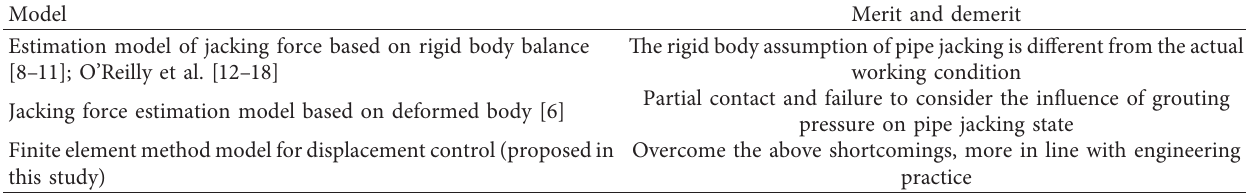
Table 1: Different models and their advantages and